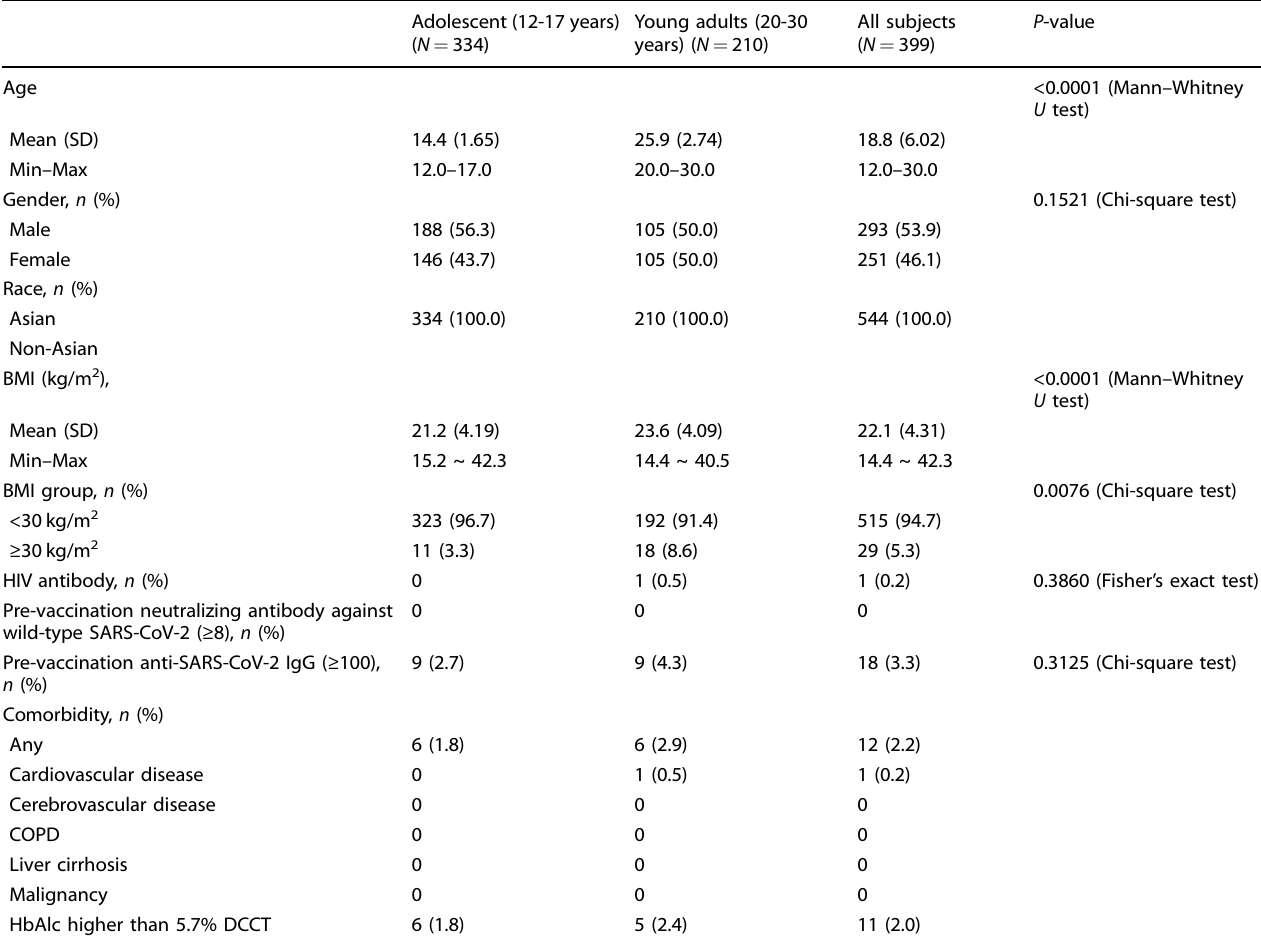
Table 2. Summary of demographics of adolescent and young adults for immunogenicity comparison (PPS